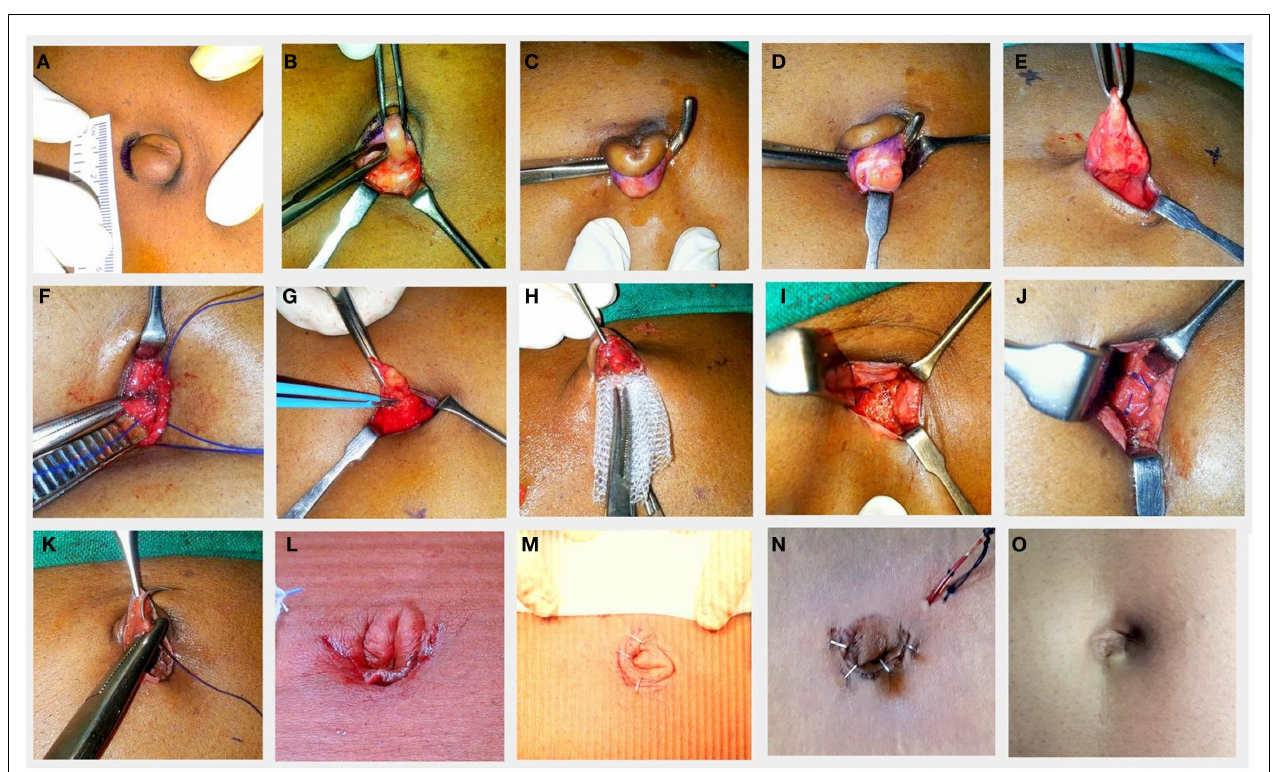
FIGURE 1 |The operative steps (A–M) .The appearance of the umbilicus 1year following surgery (O) .